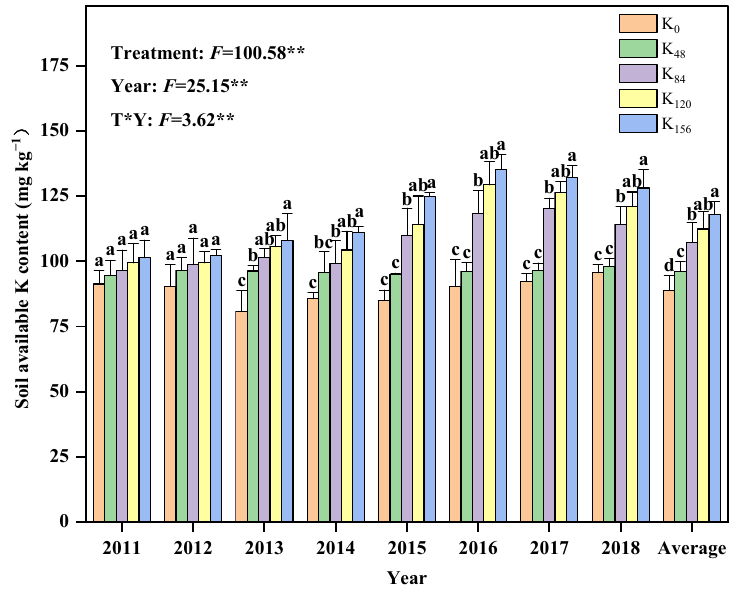
Figure 4. Effects of different K fertilization rates on soil available K content between 2010 and 2018. K 0 , no K fertilizer application; K 48 , 48 kg K ha − 1 ; K 84 , 84 kg K ha − 1 ; K 120 , 120 kg K ha − 1 ; K 156 , 156 kg K ha − 1 . Vertical T bars in the histogram indicate SE. Different letters indicate significant differences among treatments. ** Significant at the 0.01 probability level.